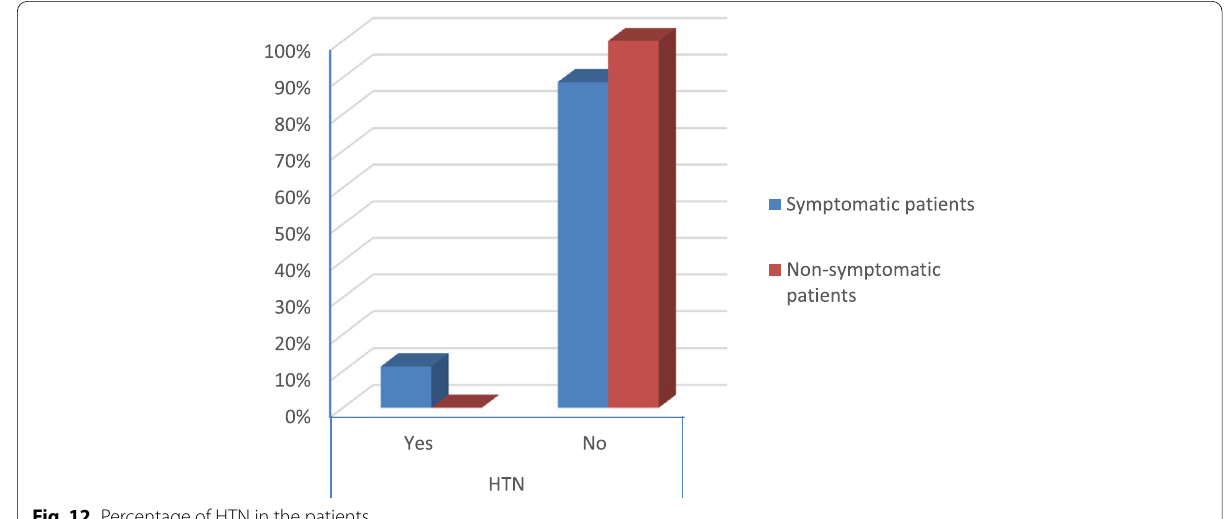
Fig. 12 Percentage of HTN in the patients